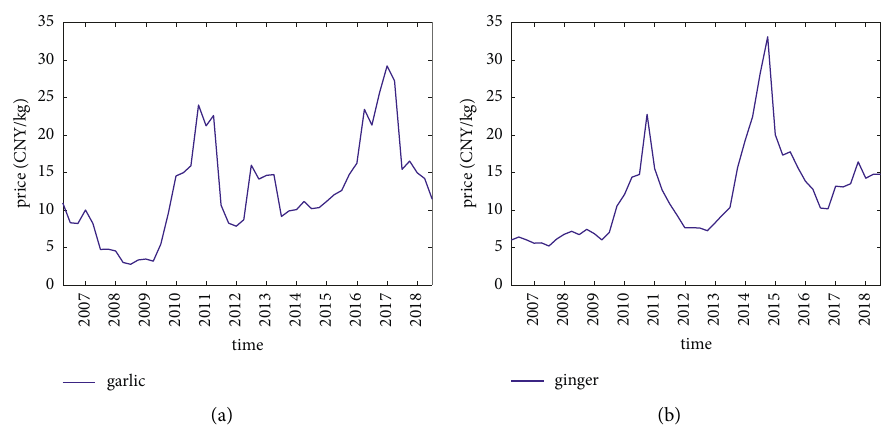
Figure 1: Quarterly price of garlic (a) and ginger (b) in China from 2006Q2 to